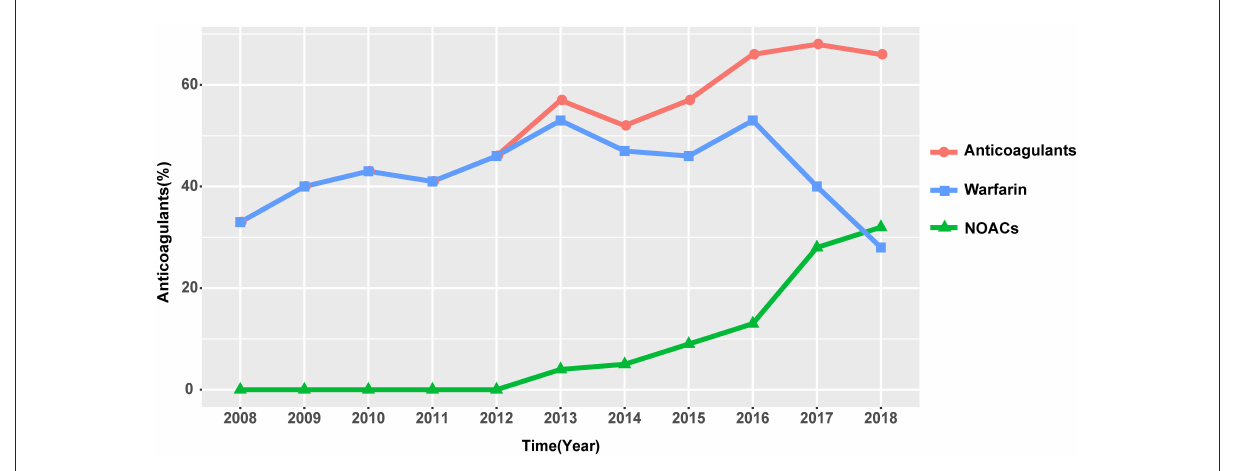
FIGURE5 Trend of anticoagulant usage over time. Abbreviations as in Figure 4.